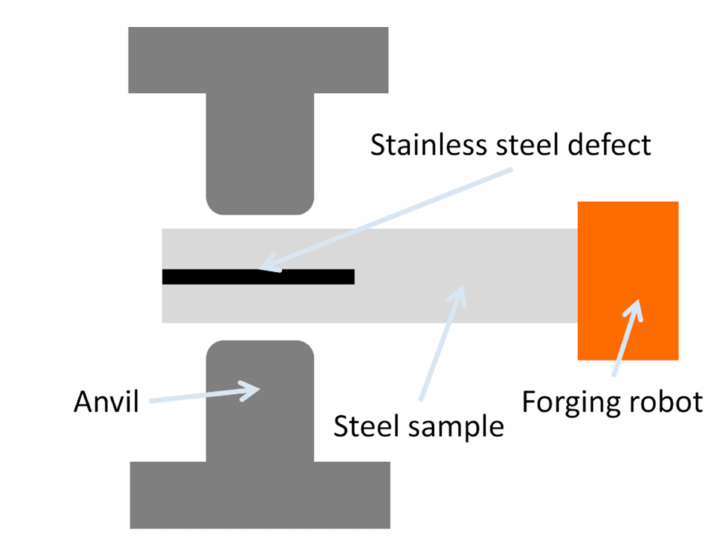
Figure 12. Experimental configuration: evolution of stainless-steel